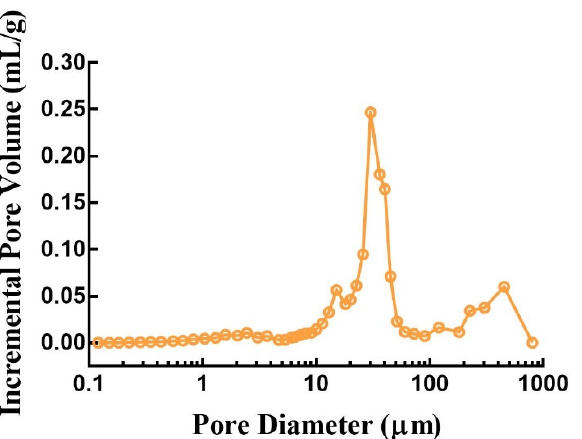
Figure 9. Internal pore size distribution of 3D-printed compound dispersible tablets.